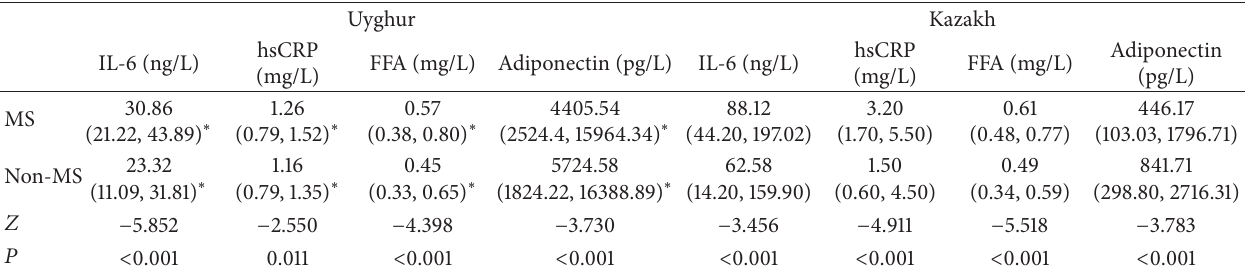
Table 2: IL-6, hsCRP, FFA and adiponectin levels of MS and non-MS groups in the Uyghur and Kazakh